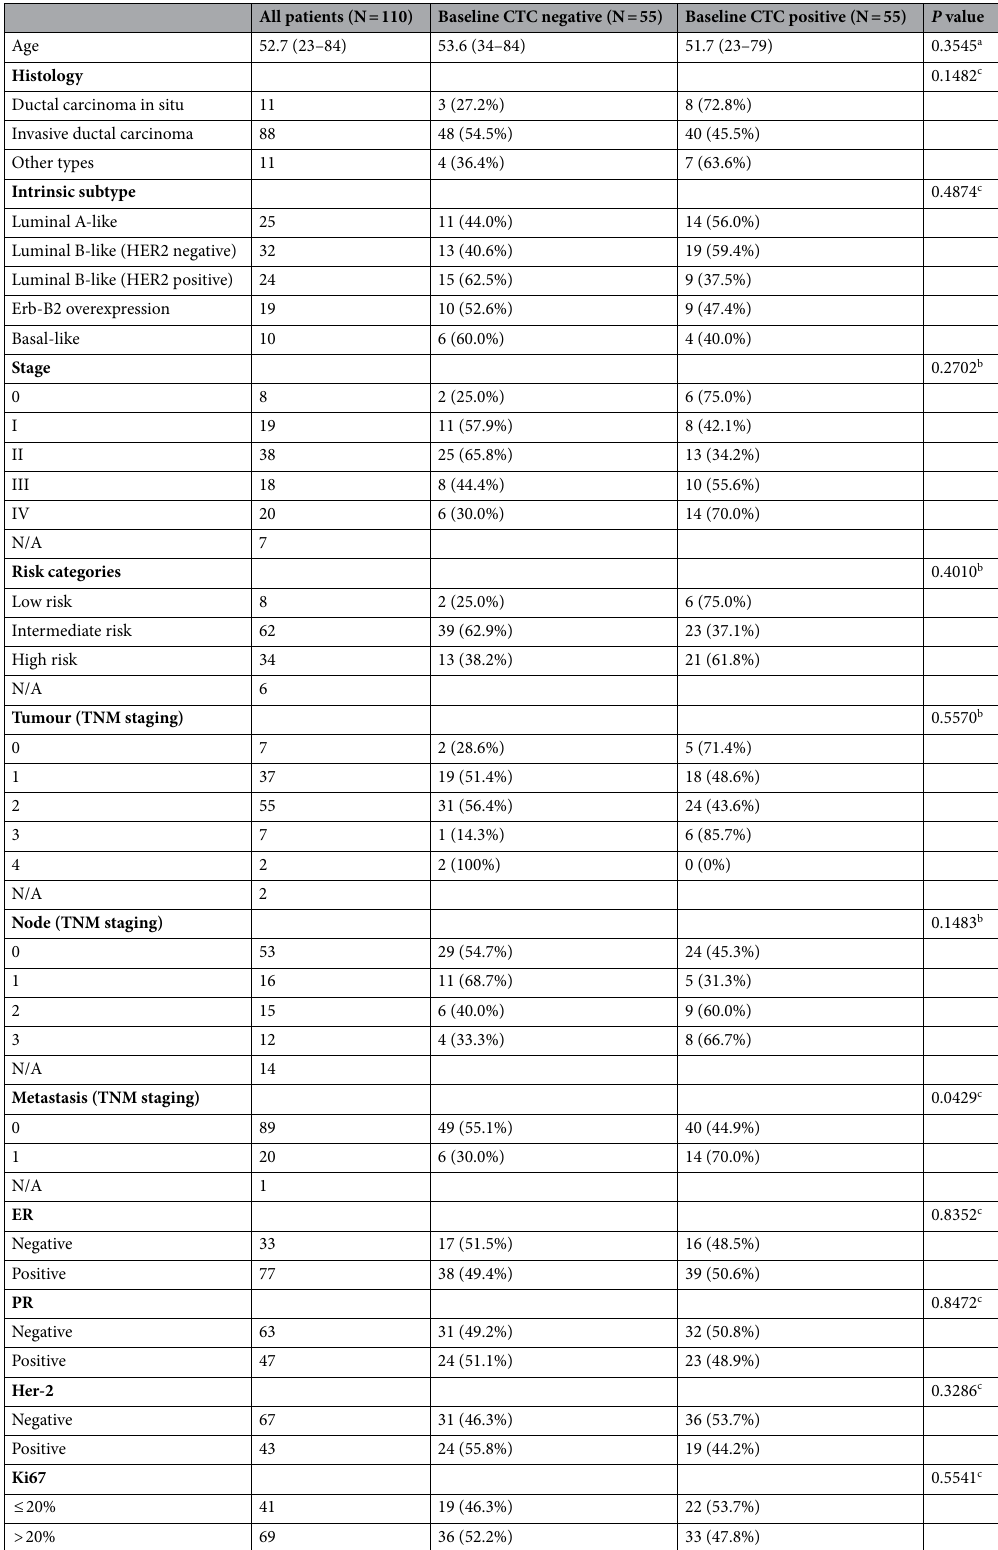
Table 1. Patient characteristics and prevalence of CTCs. a P value from Mann–Whitney test. b P value from Pearson’s chi-squared test for trend. c P value from Pearson’s chi-squared